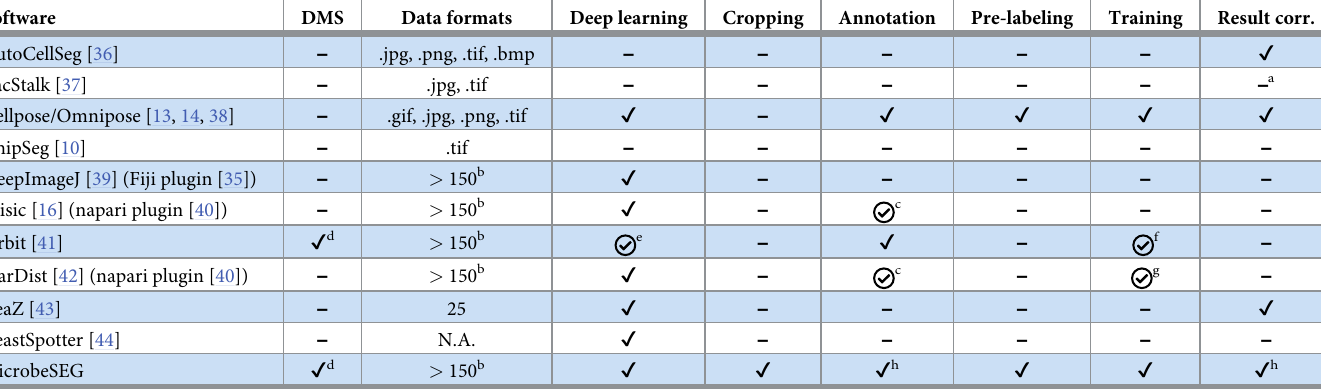
Utilizing ObiWan-Microbi for training data annotation, microbeSEG covers the whole pipe- line from training data creation, training, evaluation, and inference. Both tools are designed to work together seamlessly and use OMERO for data management. The optimized workflow allows producing high-quality segmentation results in reasonable annotation time. Our results Table 2. Cell segmentation software key feature comparison. Considered are only tools with a graphical user interface since end users should not need programming expertise. Non deep learning segmentation methods may require expert knowledge for parametrization and are not state-of-the-art anymore. Data format support does not necessarily mean that each image can be processed: if no data management system (DMS) with metadata support is used, e.g., the channel dimension can be the first or the last dimension for.tif files, and the method may have requirements on the channel dimension position. ━ : feature not fulfilled/supported, : feature only fulfilled/sup- ported with restrictions, ✔ : feature fulfilled/supported. Software DMS Data formats Deep learning Cropping Annotation Pre-labeling Training Result